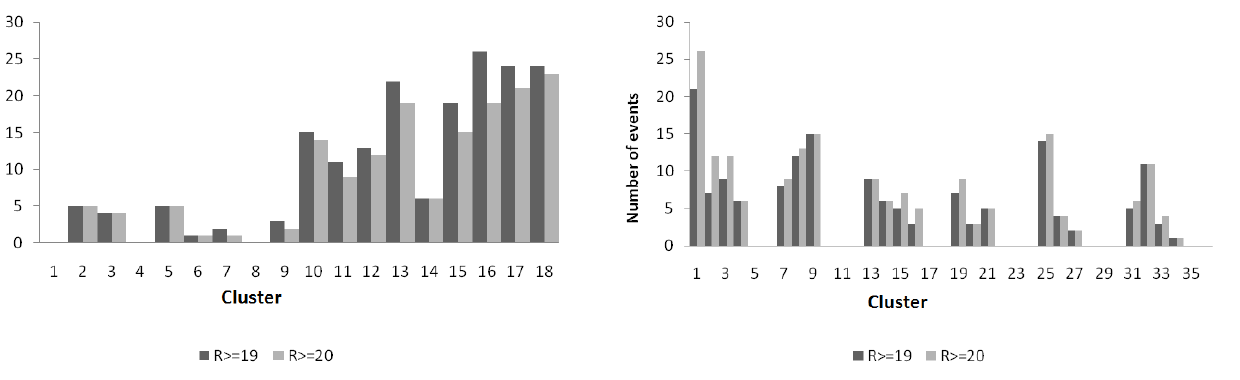
Fig. 5. Allocation of heavy rainfall events in the 18-cluster classification.